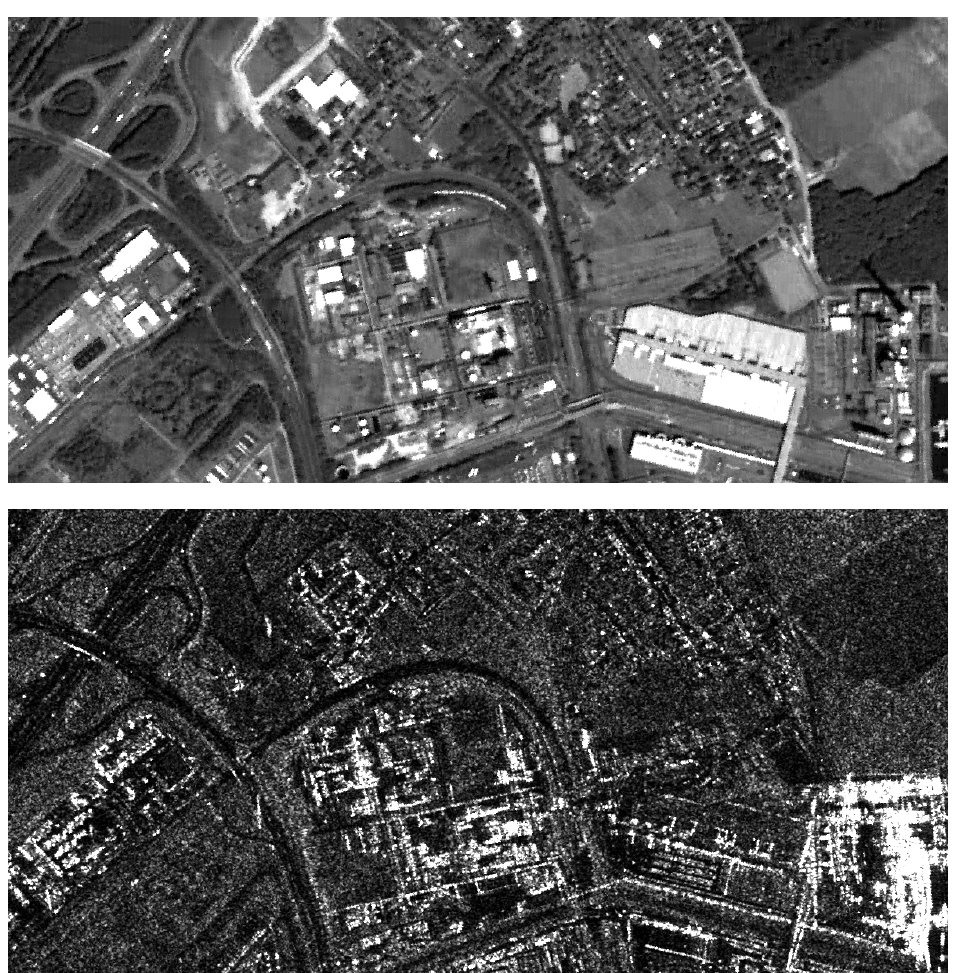
Figure 1. Visual comparison of an optical ( top ) and SAR image ( bottom ) acquired over the same area. Both images have a ground sampling distance of